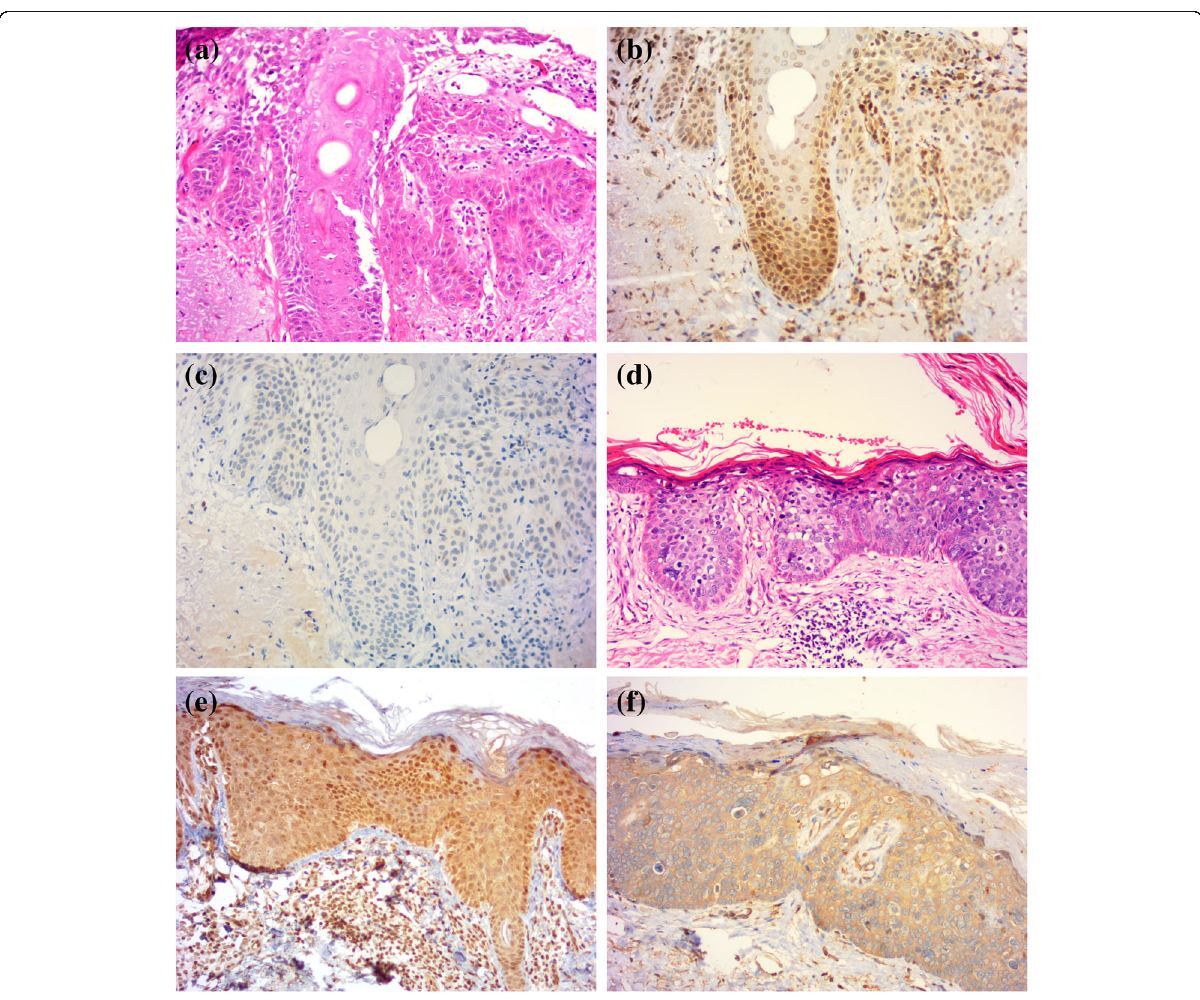
Fig. 2 AHR and CYP1A1 in AK and BD cases. a Haematoxylin and eosin stain for AK. b Strong positive AHR immunoreactivity with a nuclear pattern in AK cells. c Negative CYP1A1 immunoreactivity in AK cells. d Haematoxylin and eosin stain for BD. e Strong positive AHR immunoreactivity in both the nuclei and cytoplasm in BD cells. f Moderate CYP1A1 immunoreactivity with a cytoplasmic pattern in BD cells. (immunoperoxidase